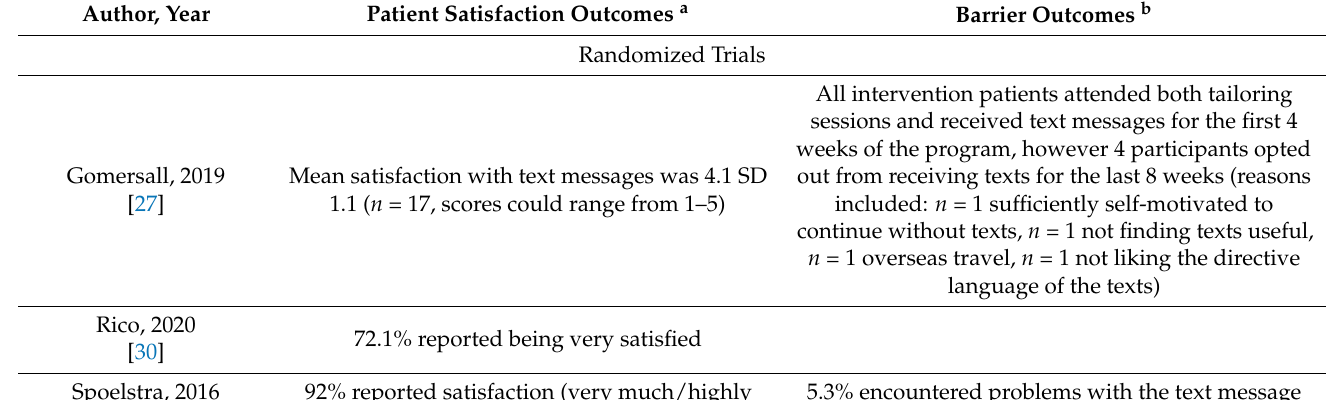
Table 2. Patient satisfaction ( n = 12 studies) and barrier ( n = 7 studies)